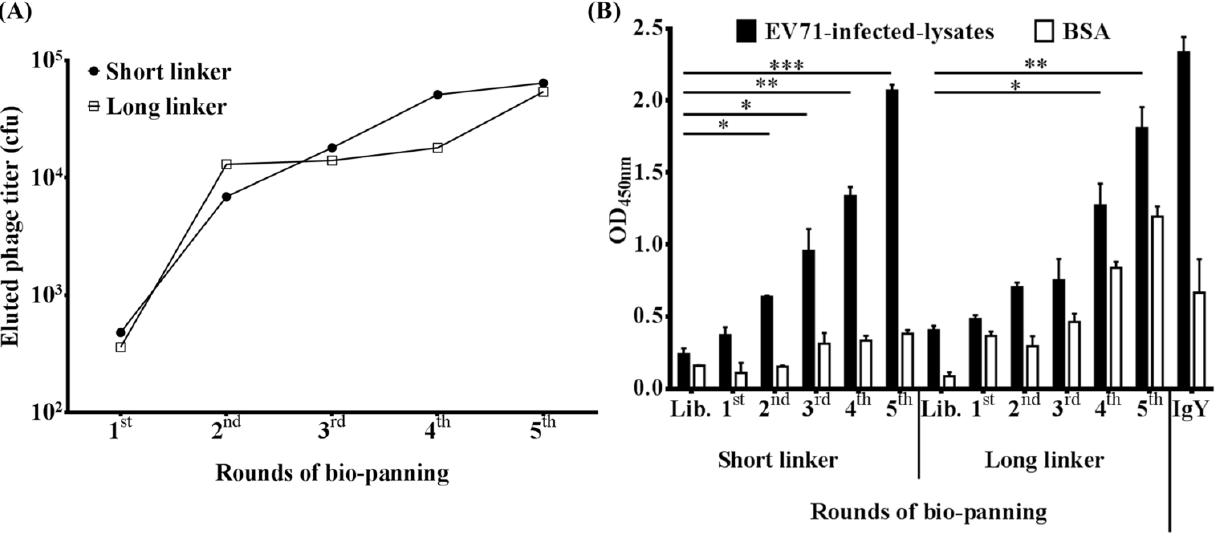
Figure 2. Determination of the phage titers and their specific binding activity after each round of bio-panning. ( A ) Two antibody libraries displaying scFv antibodies were constructed with short and long linkers and used for the bio-panning procedure. Recombinant phages were eluted to determine the colony-forming units (CFU) after each round of bio-panning. ( B ) Each amplified phage containing 10 11 to 10 12 plaque-forming units (PFU) was used as primary binders against EV71-infected lysates or BSA on phage-based ELISA. Purified IgY from the 7th immunization was used as a positive control. The labels Lib (original library phages) to 5th represent the phages isolated before and after 1 to 5 rounds of bio-panning. The experiments were performed in a duplicated manner and statistically analyzed as mean ± SD. *, p < 0.05; **, p < 0.01; ***, p < 0.001.